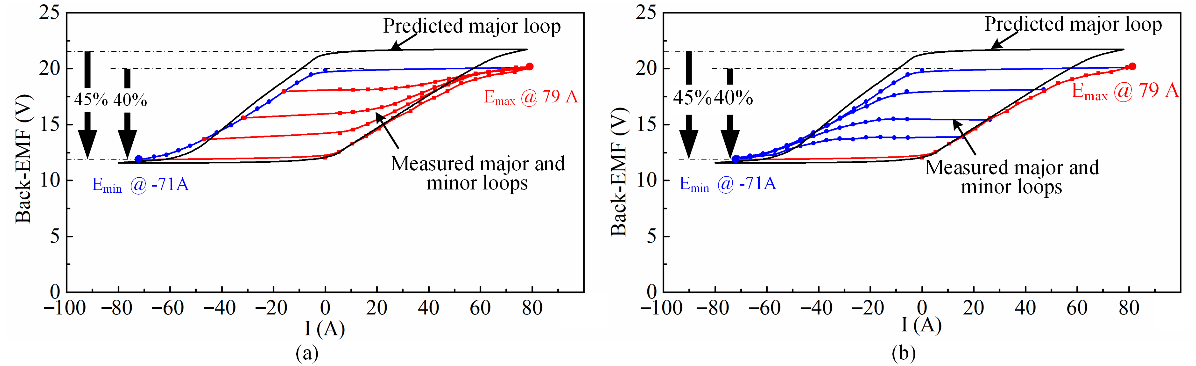
Figure 22. Resultant back-EMF hysteresis loop after magnetizing and demagnetizing from different initial magnetization states. ( a ) Magnetizing process; ( b ) demagnetizing process.